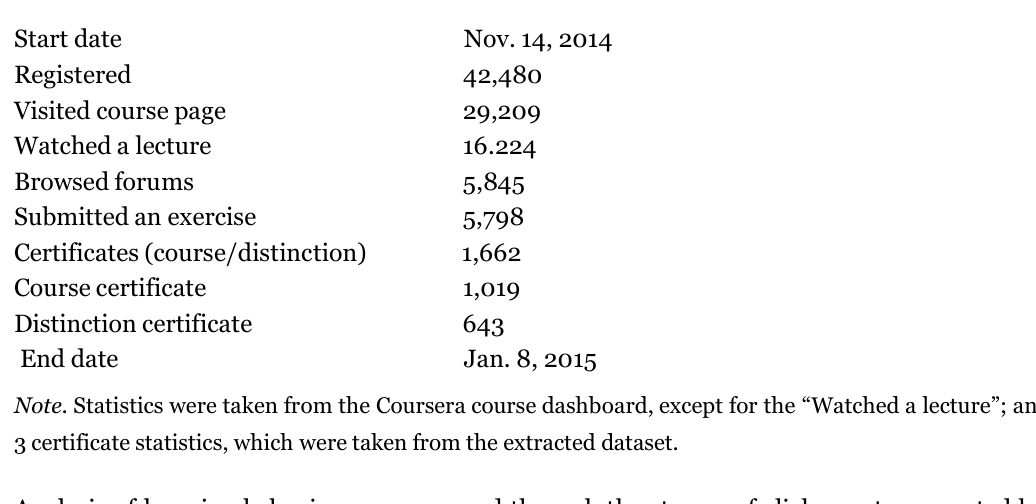
Global Statistics for the First Run of the MOOC Process Mining: Data Science in